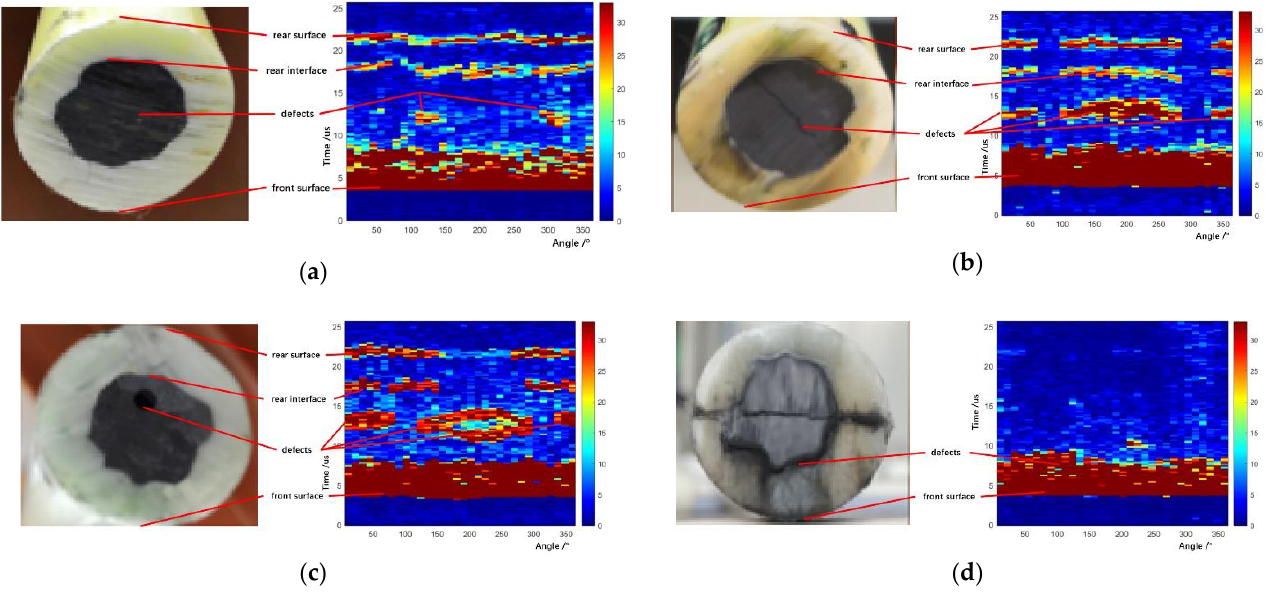
Figure 8. Multi-information fusion into an image.